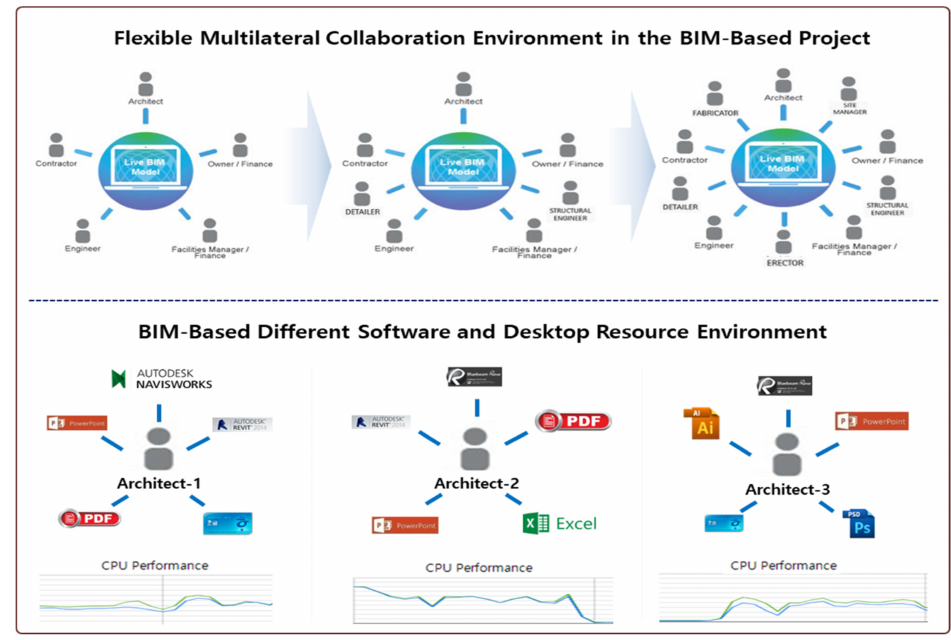
Figure 2. Considerations on the use of VDI in a BIM-based project.